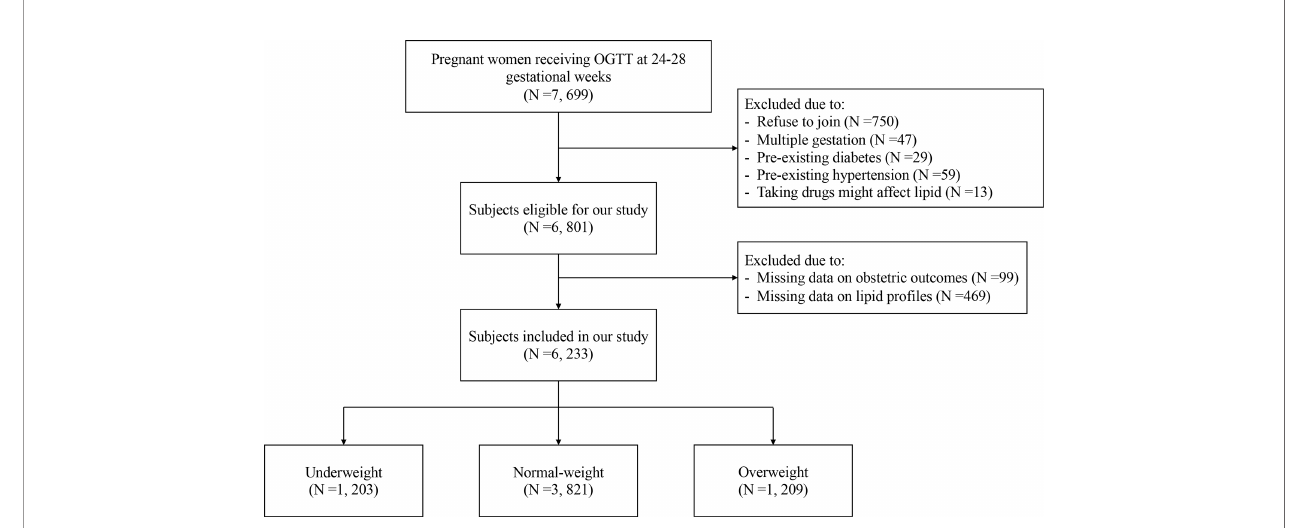
FIGURE 1 | Flow chart of selecting eligible subjects. OGTT, oral glucose tolerance test.